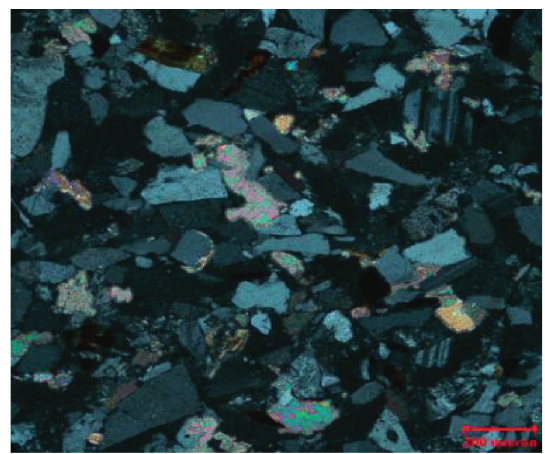
Figure 1: Microscopic image of the sandstone